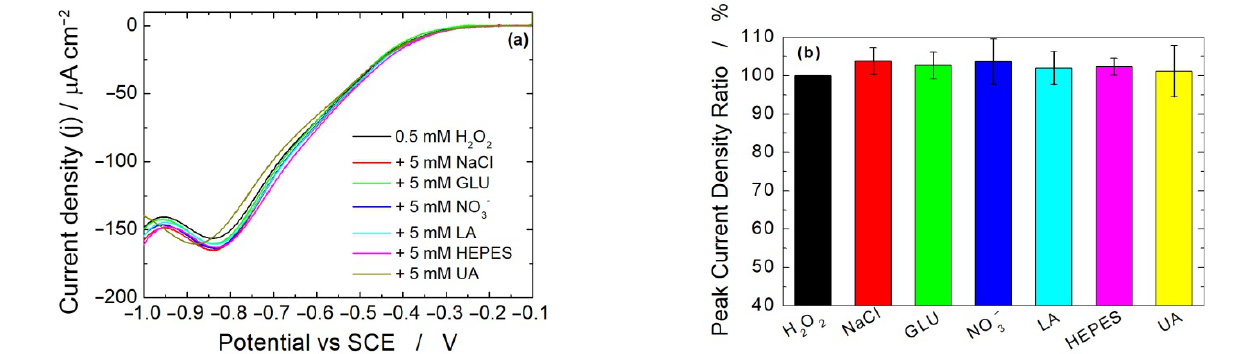
Figure 6. ( a ) LSV experiments carried out in MEM alone in the presence of 0.5 mM H 2 O 2 and 5 mM of interfering species and ( b ) corresponding interference of each chemical on sensor output (N = 3).